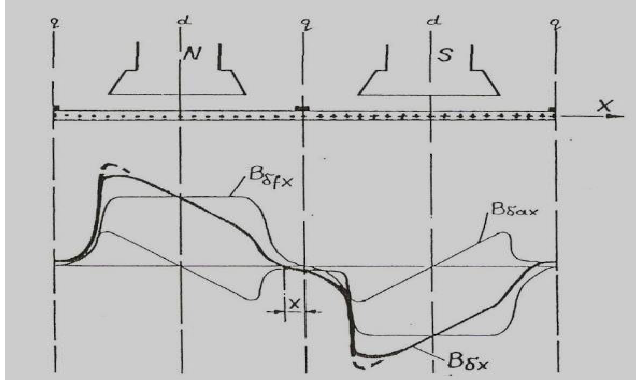
Figure 4. Resultant magnetic field of the direct current engine with brushes placed in axis q .